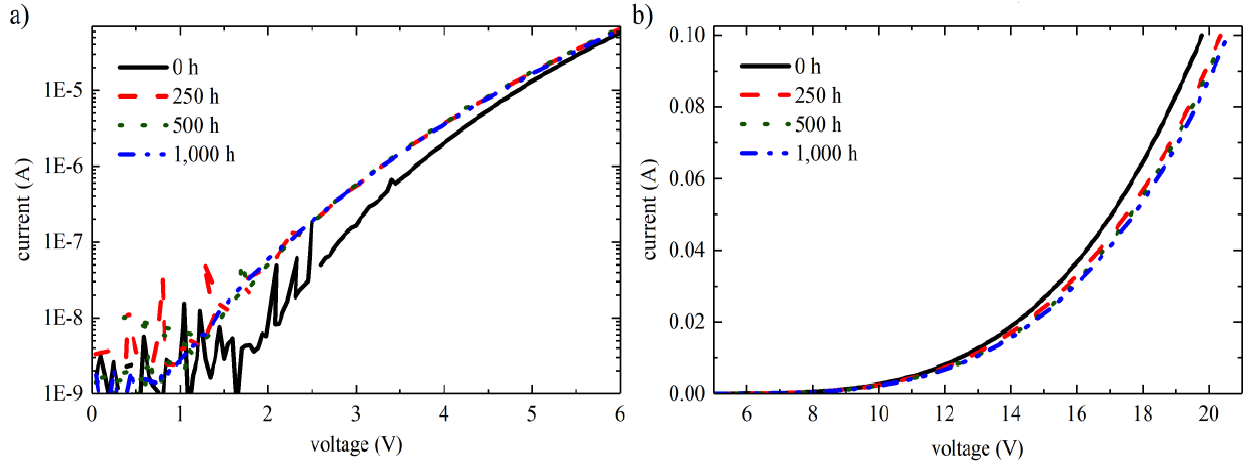
Figure 22. Current-voltage characteristics ( a ) below and ( b ) above the turn-on voltage. Reproduced with permission. [36] Copyright 2018, IOP Publishing.